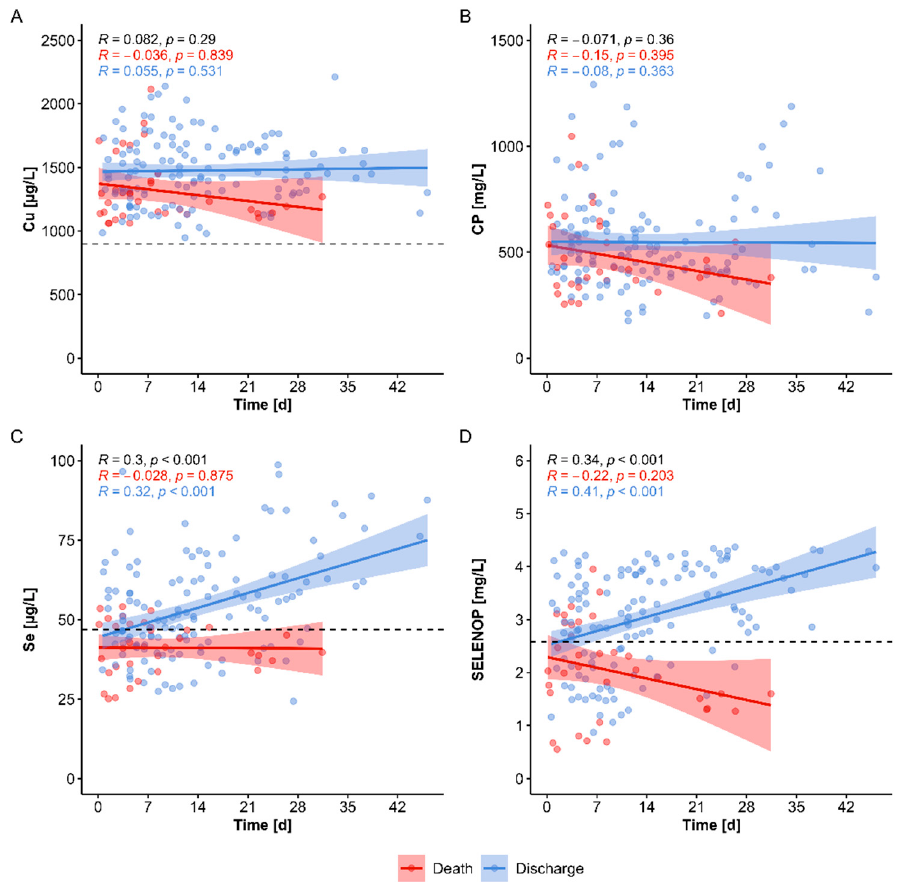
Figure 3. Comparison of dynamic changes in biomarkers of Cu and Se status in relation to survival. Serum samples from different time points after hospital admittance were available form surviving (blue) and non-surviving (red) COVID-19 patients. ( A ) Total serum Cu concentrations showed no obvious alterations over time during the hospital stay, and were only slightly different between COVID-19 survivors and non-survivors. ( B ) Significant alterations over time were not observed in serum CP concentrations of patients with COVID-19. The stability in Cu status is different to the dynamic changes observed before in the biomarkers of Se status, where ( C ) total serum Se and ( D ) SELENOP concentrations recovered during hospital stay in surviving patients only. Thresholds for deficiencies (broken lines), Spearman correlation coefficients ( R ) and p -values are indicated.